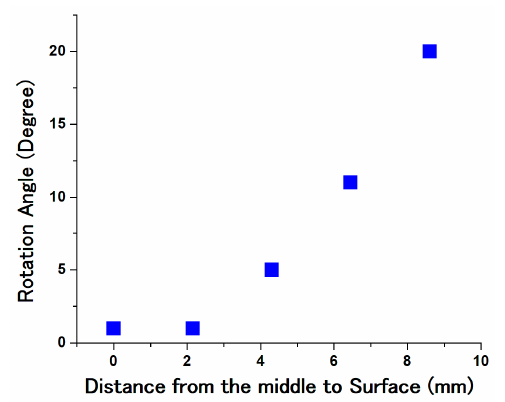
Figure 10. Transition from β -fiber to the <111> // ED fiber.